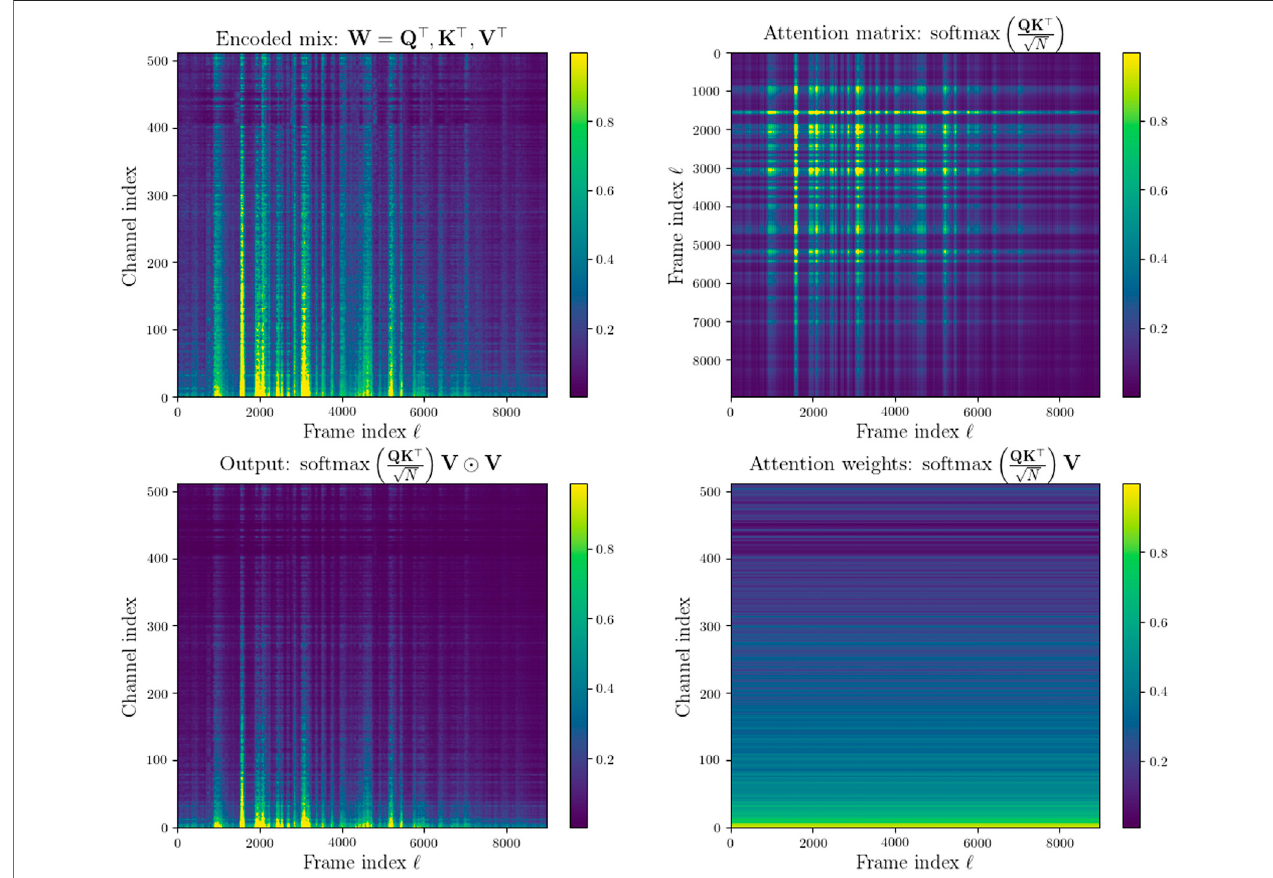
FIGURE 4 | Top left: encoded NRSM signal. Top right: Computed attention matrix weights. Bottom right: Scaled dot product attention. Bottom left: encoded NRSM signal re-weighted with attention. The fi gures on the left have had values above 0.05× their maximum values clipped and are normalized between 0 and 1. The fi gures on the right are normalized between 0 and